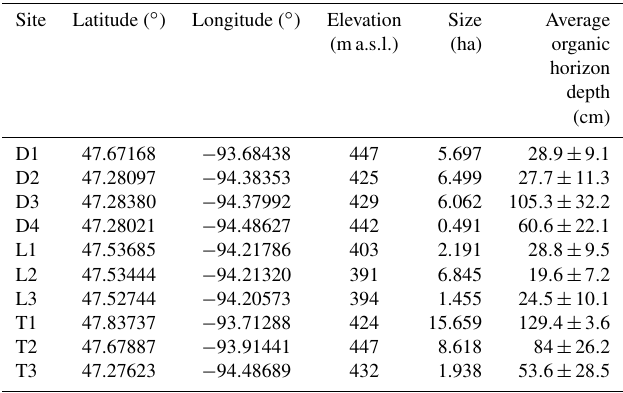
Table 1. Site information for 10 black ash study